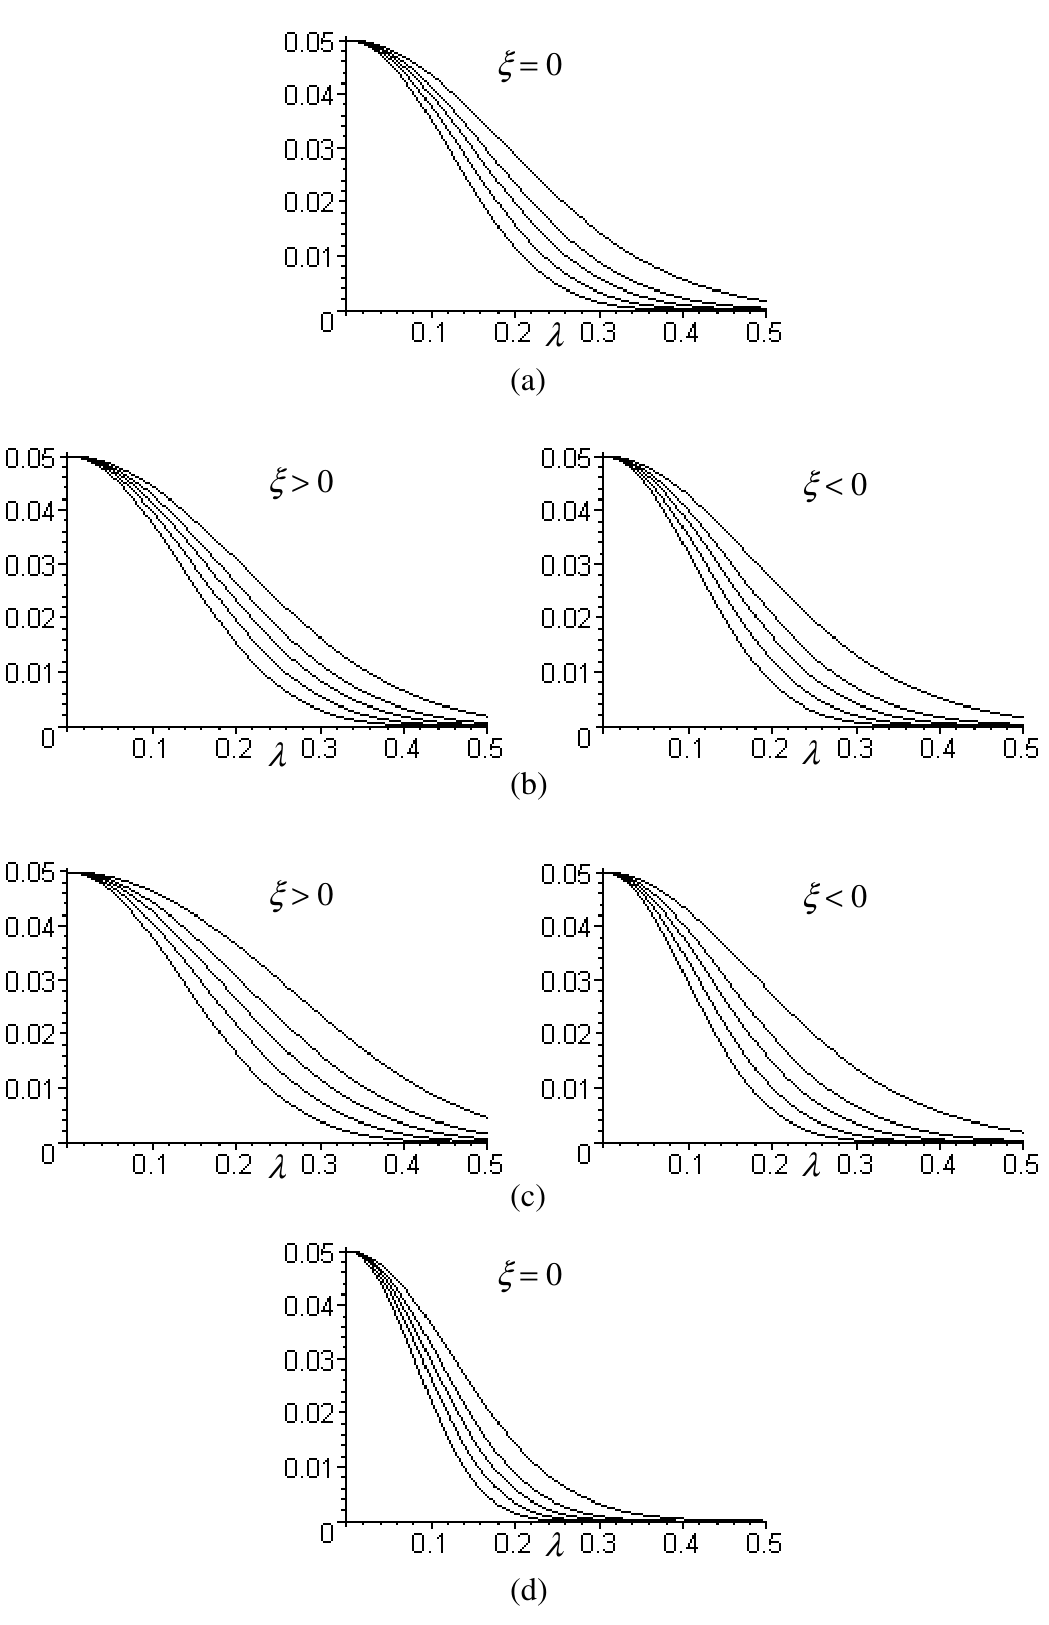
Fig. 1. Plots of α G versus λ with r = 1, N = 30, 50, 70, 100, 150 (top to bottom), u = 0 . 5, v = 1 . 2, δ = 0 . 3, α = 0 . 05 for (a) c = 1, C (cid:2)(cid:2) p = 1; (b) c = 1, C (cid:2)(cid:2) p = 1 . 5; (c) c = 1, C (cid:2)(cid:2) p = 2; (d) c = 1 . 5, C (cid:2)(cid:2) p = 1 . 5; (e) c = 1 . 5, C (cid:2)(cid:2) p = 2; (f) c = 1 . 5, C (cid:2)(cid:2) p = 2 .